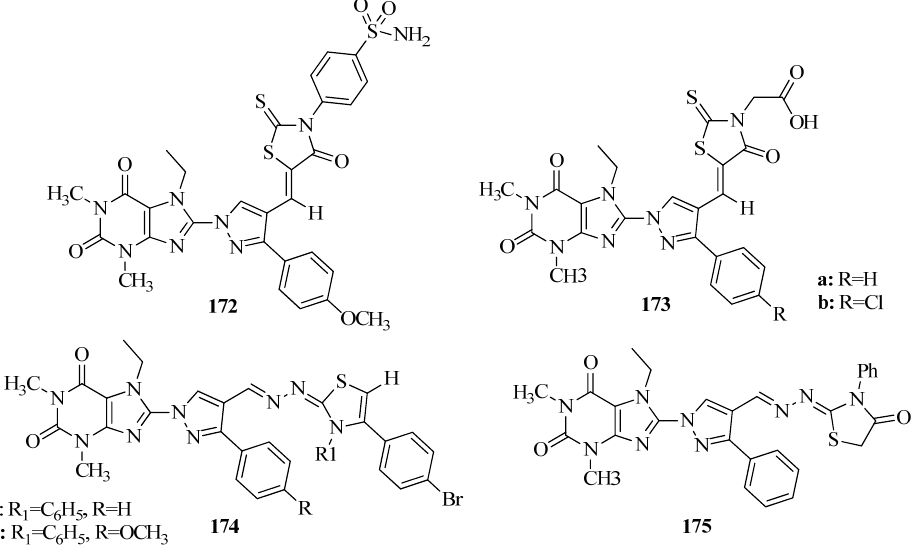
Figure 67. Structures of purine–pyrazole hybrids bearing thiazole